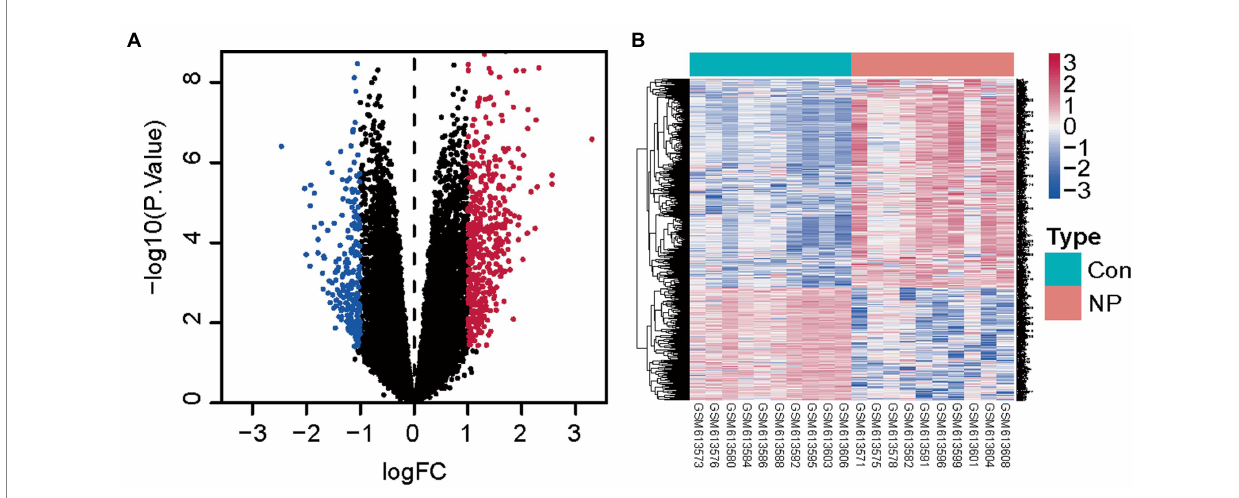
FIGURE 1 Genes differentially expressed between the neuropathic pain and normal groups. (A) Volcanic map for differential expression analysis of GSE24982. (B) Heat map for differential expression analysis of GSE24982. Blue represents down-regulated genes, red represents up-regulated genes, and black represents undifferentiated genes.